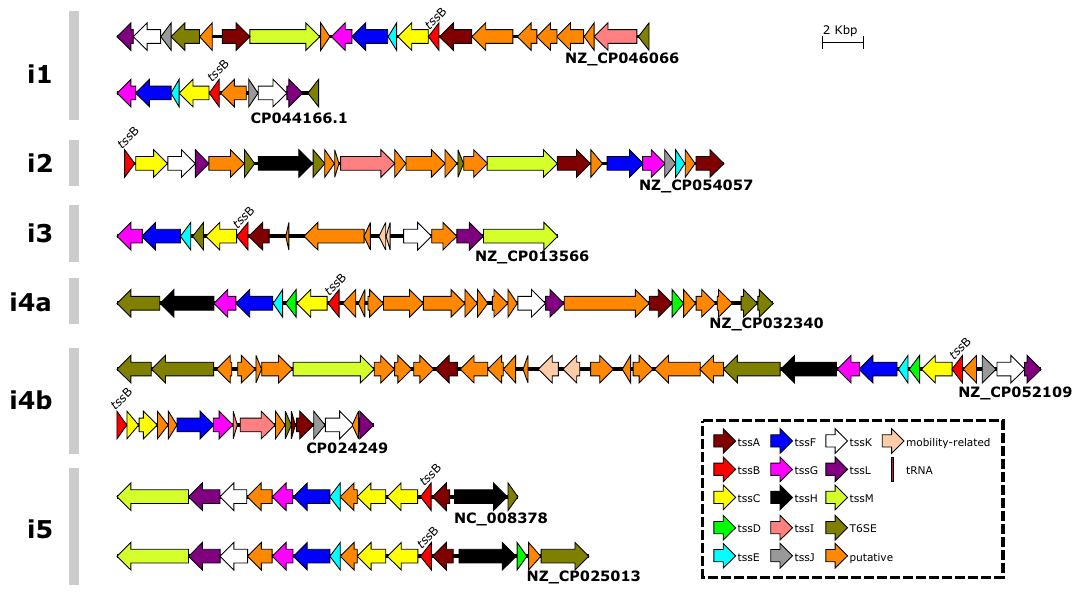
Figure 3. Genetic architecture of T6SS gene loci of different type i